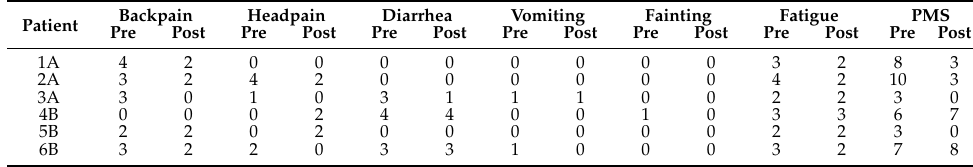
Table 3. Intensity of additional symptoms.